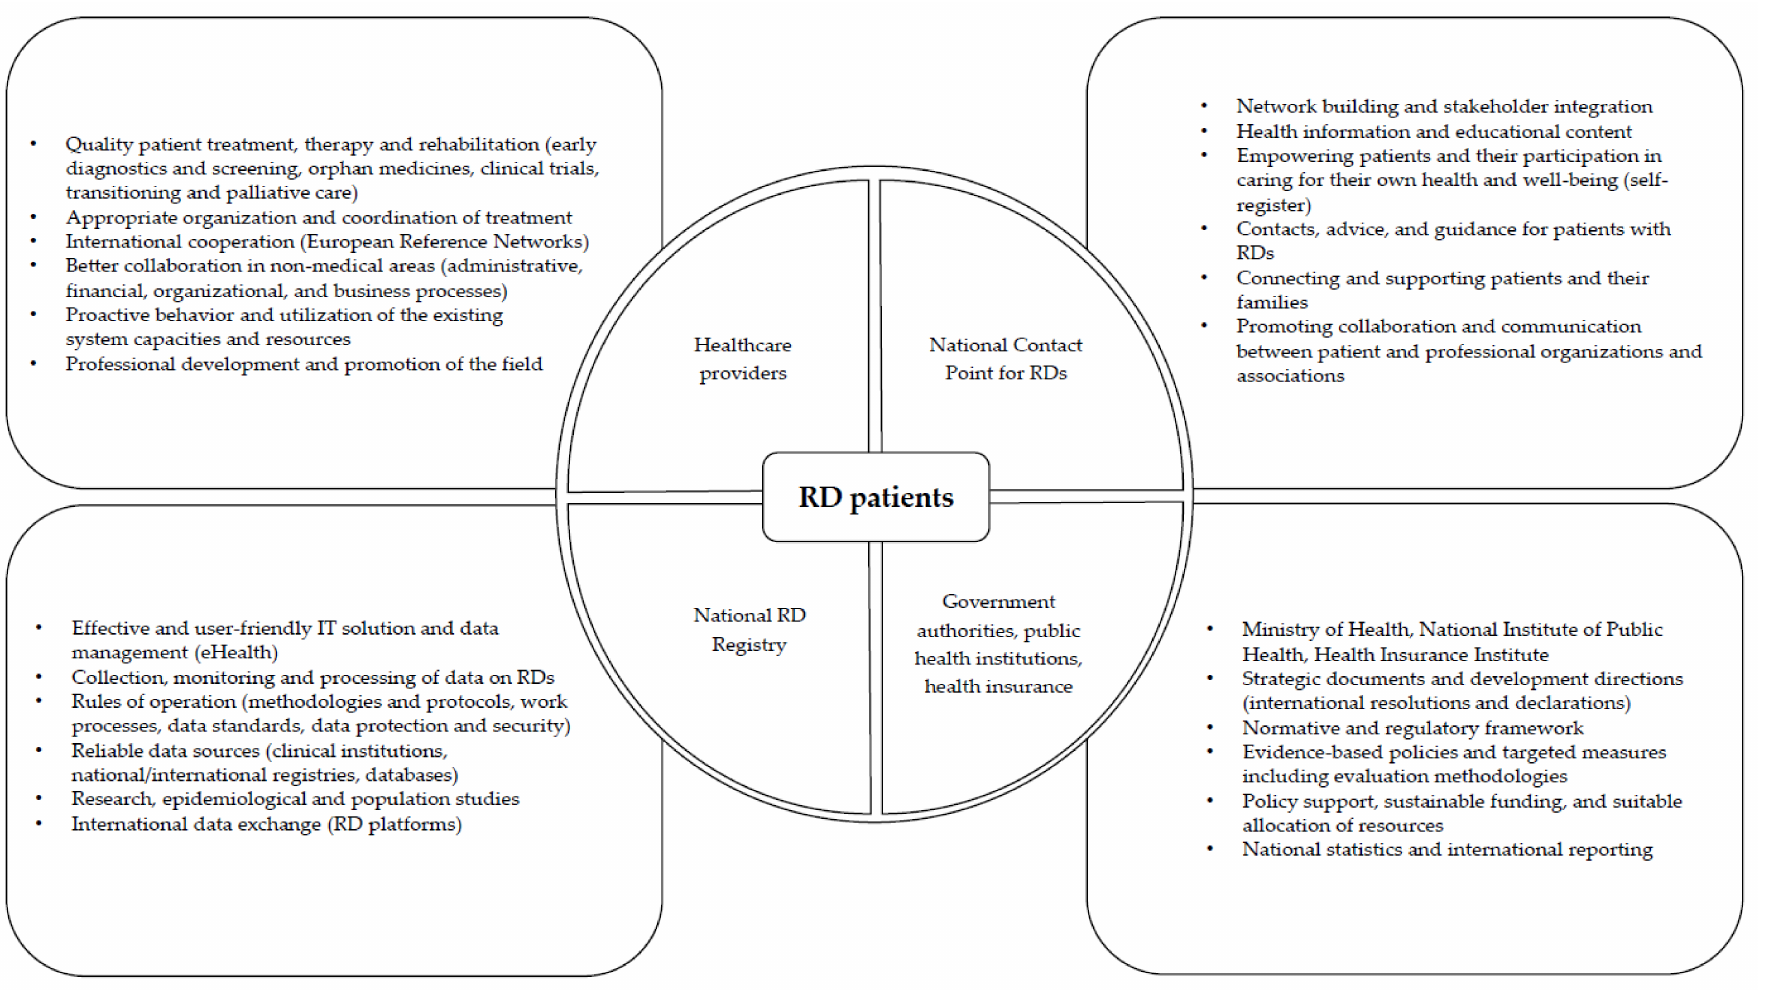
Figure 1. An outline of the proposed IT-enabled RD ecosystem in